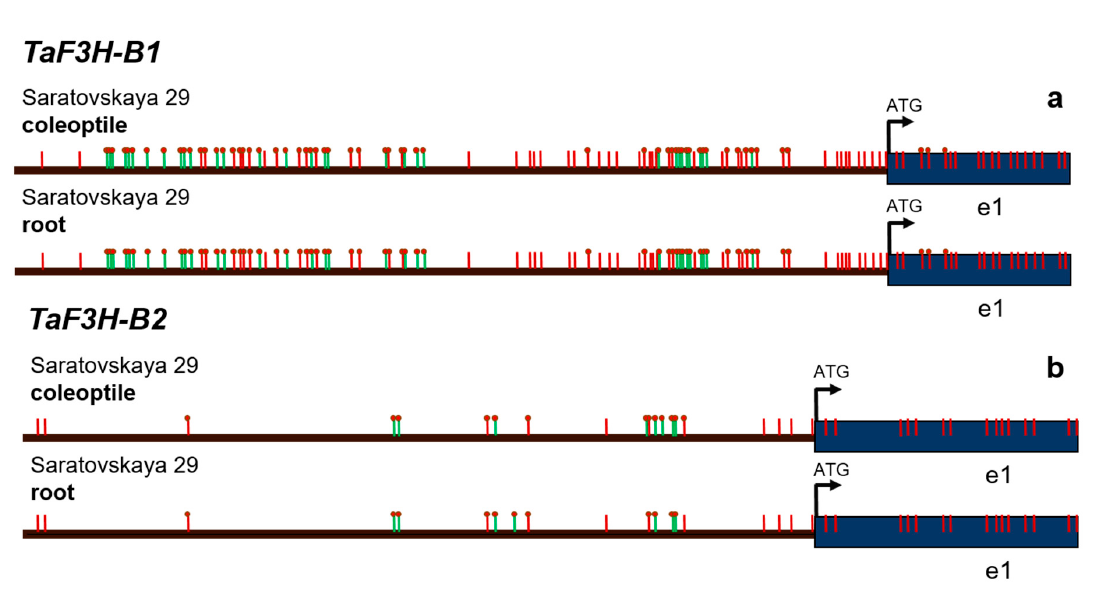
Figure 4. Methylation patterns of promoter regions for the ( a ) TaF3H-B1 (737 bp) and ( b ) TaF3H-B2 (598 bp) genes in the wheat coleoptile and roots. Arrows indicate the primers. Vertical red strokes are the predicted methylation sites. Vertical green strokes are the detected non-canonical methylation sites. Red circles mark the detected methylation